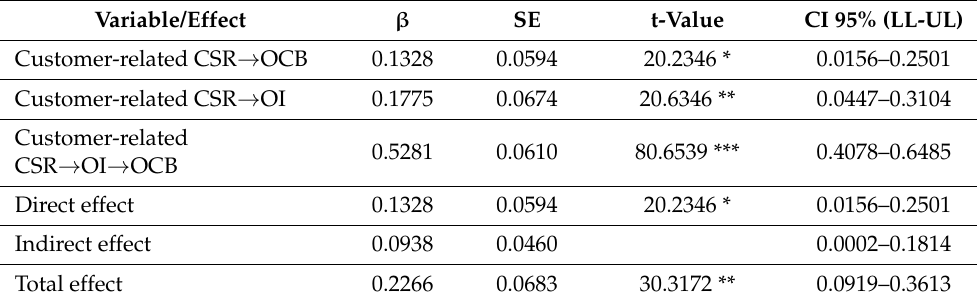
Table 6. Regression Coefficients, Standard Errors, and Model Summary Information (Mediation Model_Customer-related